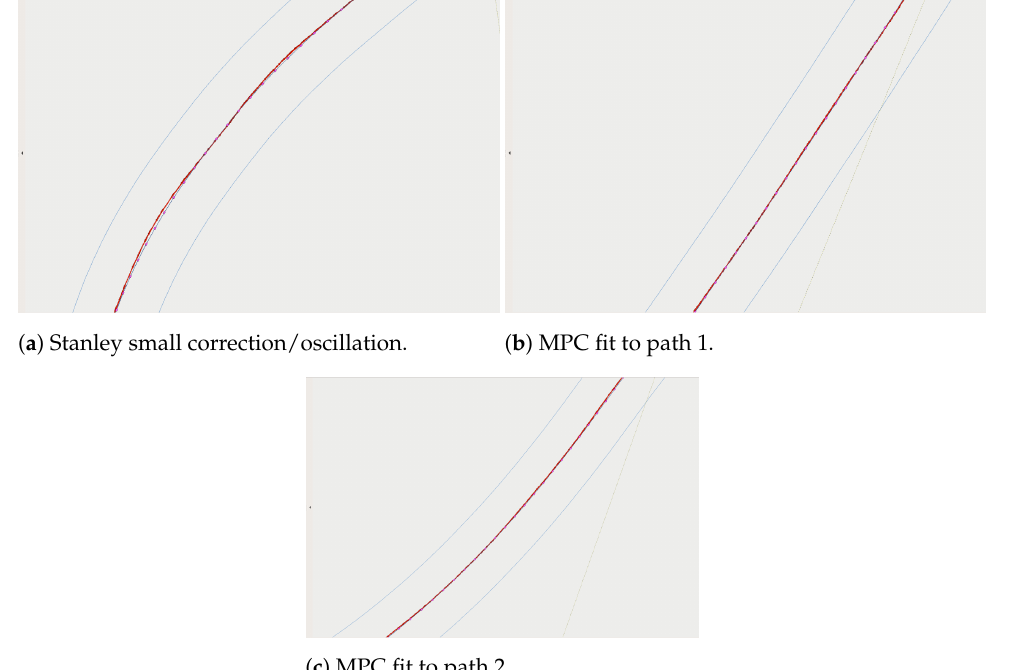
Figure 15. Lateral control